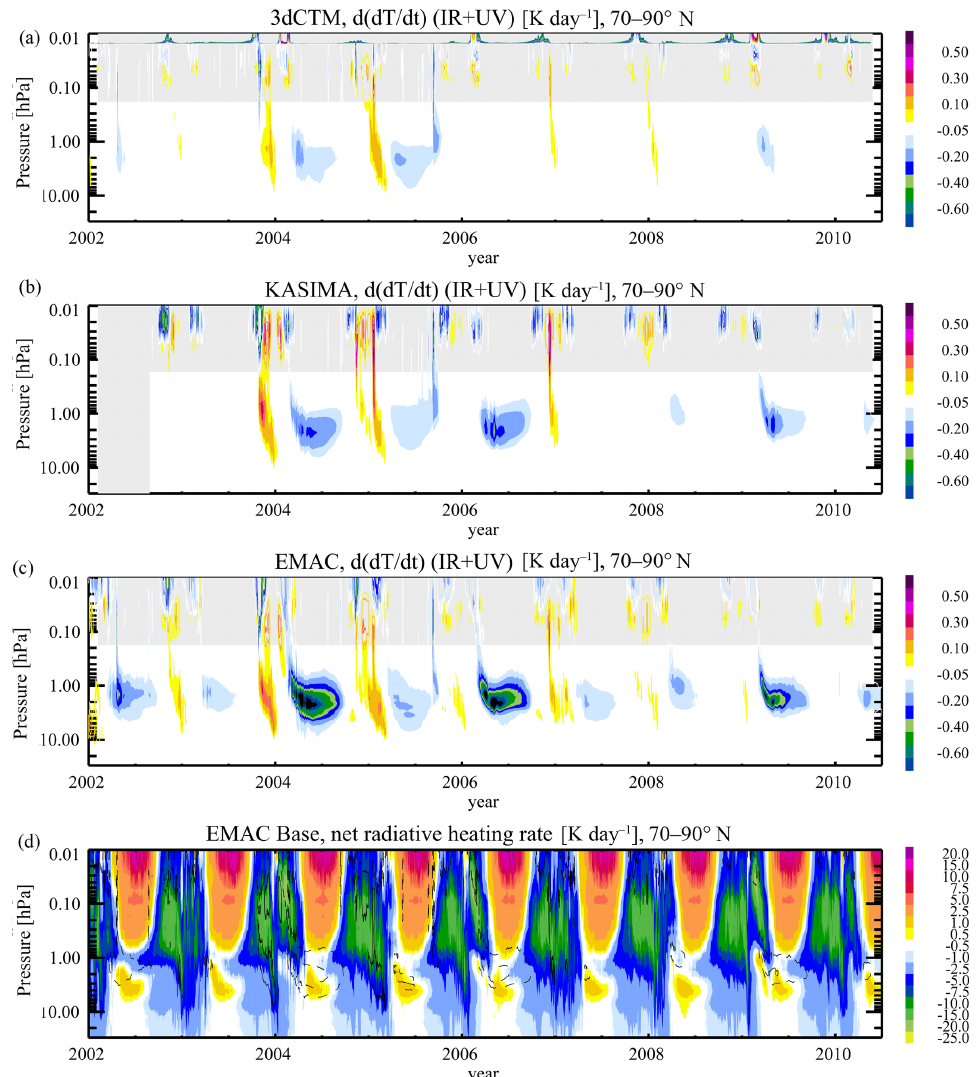
Figure 15. Changes in daily net radiative (shortwave and longwave) heating rates (Kday − 1 ) due to particle-induced ozone changes derived from all three models ( a : 3dCTM; b : KASIMA; c : EMAC) at high northern latitudes (70–90 ◦ N). (d) The net radiative heating rate (sum of the shortwave and longwave contributions) in the EMAC Base scenario (Kday − 1 ). Black dashed lines are the − 0.1 and − 0.5Kday − 1 contours of the net radiative heating rate change in EMAC; black solid lines are the + 0.1 and + 0.5Kday − 1